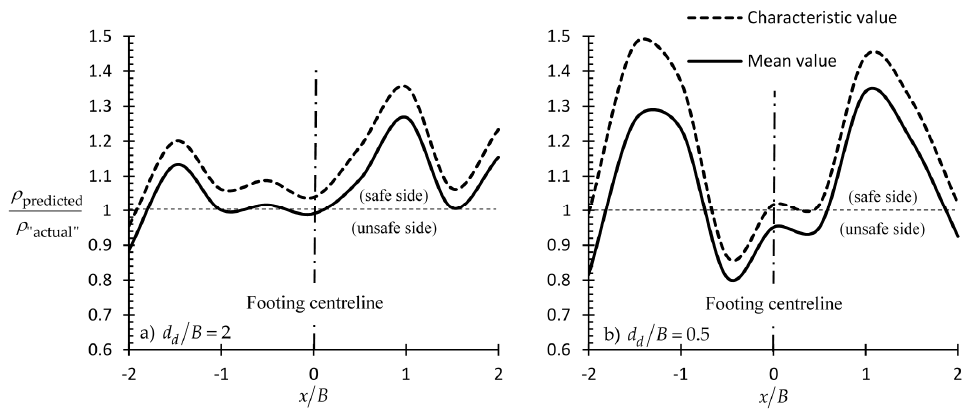
Figure 15. ρ predicted / ρ (cid:48)(cid:48) actual (cid:48)(cid:48) vs. x / B curves using both mean and characteristic values (solid and dashed lines respectively). Figure referring to two sampling domain cases: ( a ) d d / B = 2 and ( b ) d d / B = 0.5.